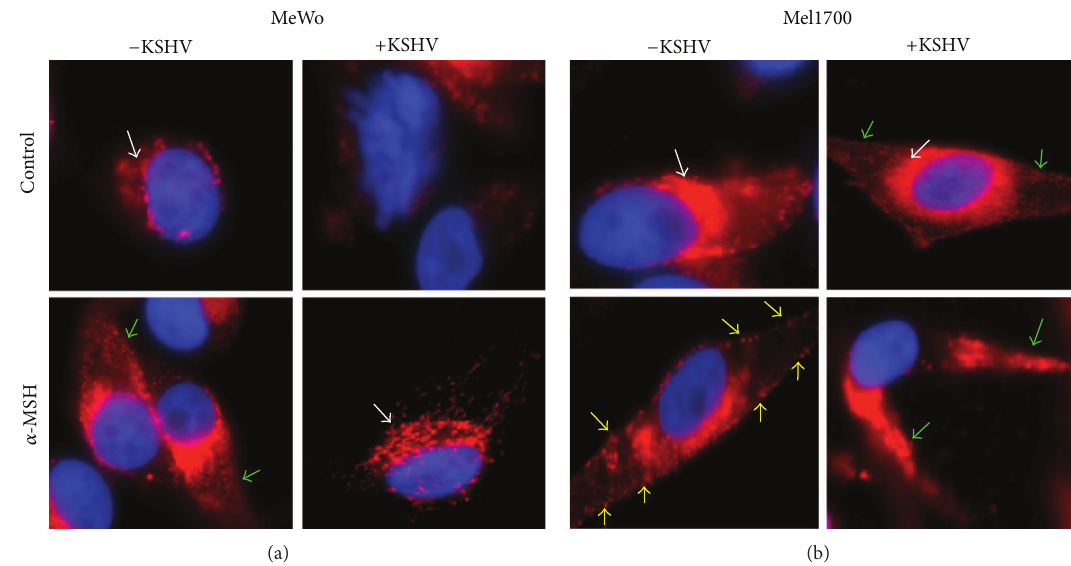
Figure 8: KSHV impairment of the melanogenic response is a virologic correlate of latency in skin cells. Uninfected ( − ) and rKSHV.219- infected (+) MeWo cells (a) or Mel1700-cells (b) were plated on chamber slides without (control) or with 𝛼 -MSH and allowed to adhere overnight. Cells were then fixed, permeabilized, and stained with anti-TRP-1 antibody and counterstained with DAPI nuclear stain. Shown are representative 63x magnification (oil immersion) images of representative cells from each field of view. White arrows depict ER/Golgi- associated TRP-1 (apparently present in untreated MeWo and in 𝛼 -MSH-treated MeWo-KSHV cells), whereas green arrows point to outgrowths of promelanogenic dendritic spines induced by 𝛼 -MSH in MeWos ((a) bottom left) and in KSHV-infected Mel1700, in which they appear to increase even more profoundly upon treatment with 𝛼 -MSH (b). For wide-view 20x images of the same treatments, please see Figure